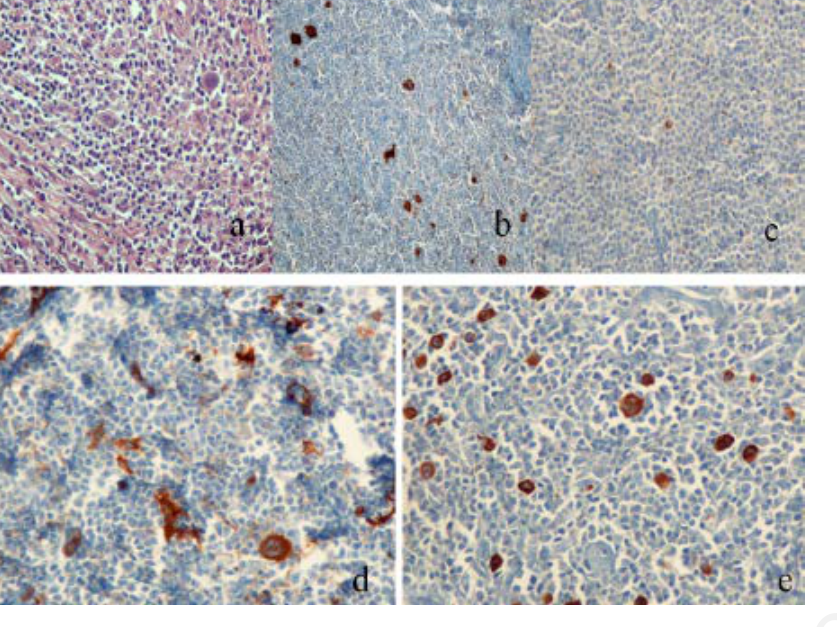
Figure 3. Microscopic